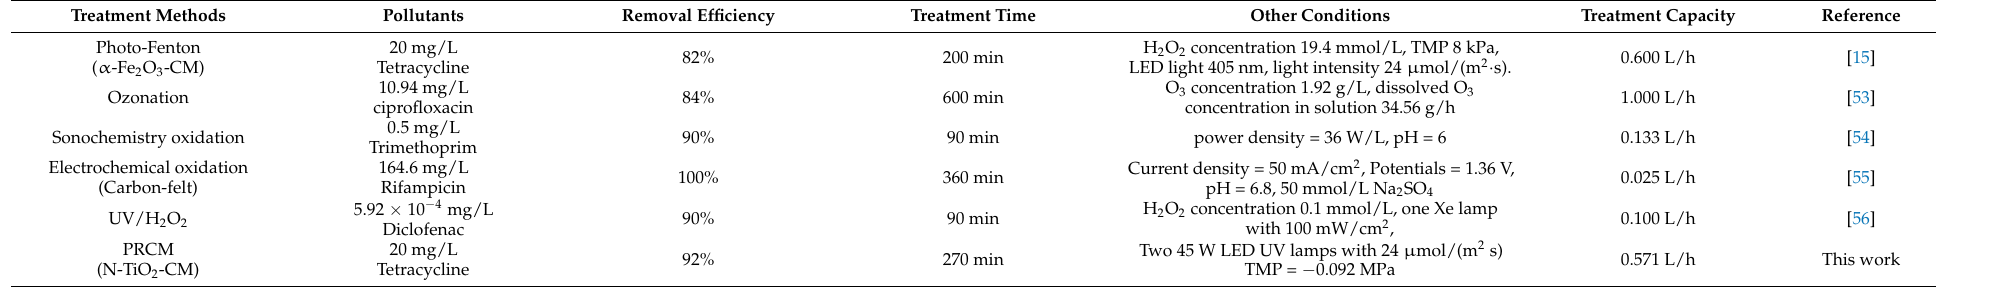
Table 2. Different advanced oxidation technologies degrade